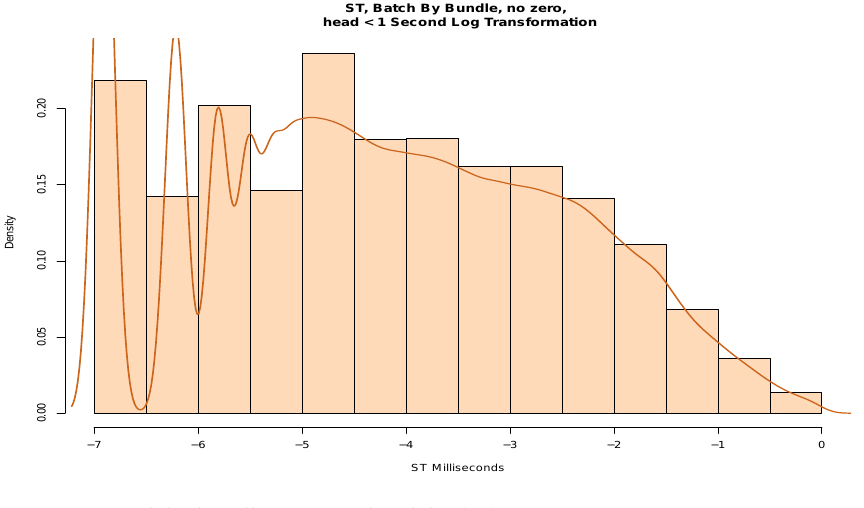
Figure 14. Batch by bundle, message head,